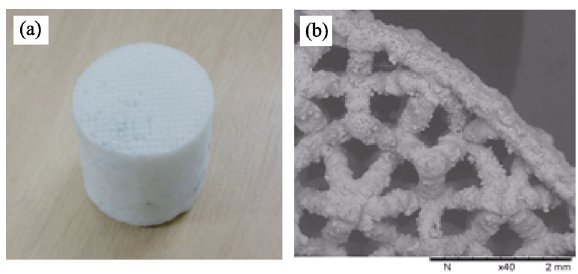
Fig. 12 Catalyst bed cellular structure: (a) optical image, (b) magnified SEM image. Reproduced with permission from Ref. [113], © Elsevier B.V. 2017.